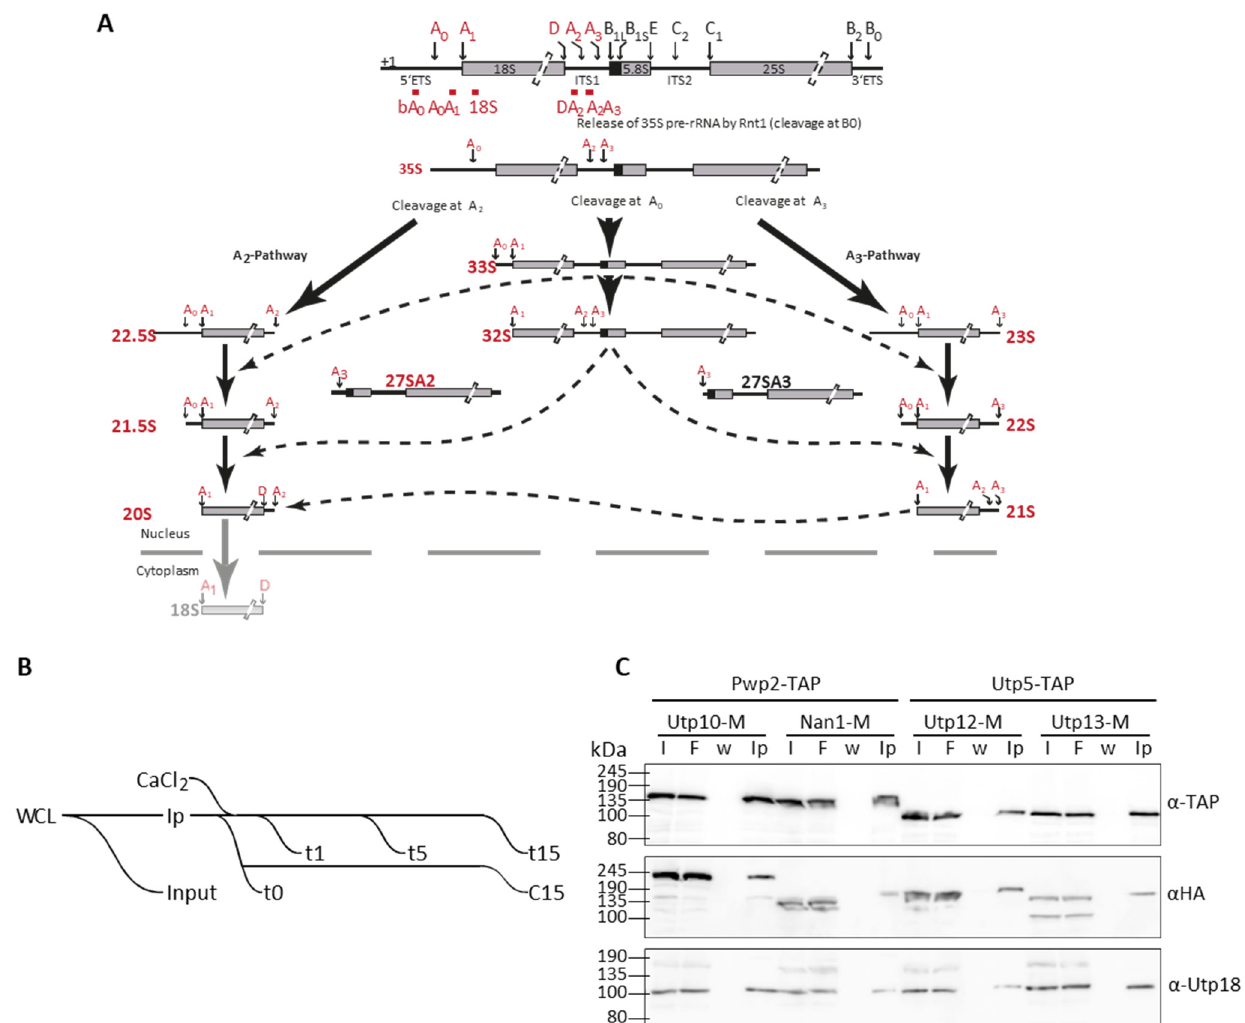
Figure 1. Processing of rRNA and structural probing assays. ( A ) Scheme for the processing of pre- rRNA to produce the 18S rRNA. Alternative cleavage pathways were described [8]. ( B ) Experimental workflow. Whole-cell lysates (WCL) were obtained for affinity purification (Ip). A fraction of WCL was used as input fraction for protein and RNA analyses. Affinity purified samples were incubated in the presence of Ca 2+ to activate MNase activity for the indicated time. Two aliquots of samples non-treated with Ca 2+ were collected as control samples, t0 before Ca 2+ addition and c15 after 15 min of incubation in the absence of Ca 2+ . ( C ) Different affinity purification fractions were analyzed by western blotting with indicated antibodies (anti-TAP, anti-HA, and anti-Utp18). I, input fraction from WCL; F, flow-through or unbound fraction to the affinity matrix; w, last wash fraction; Ip, affinity-purified samples.